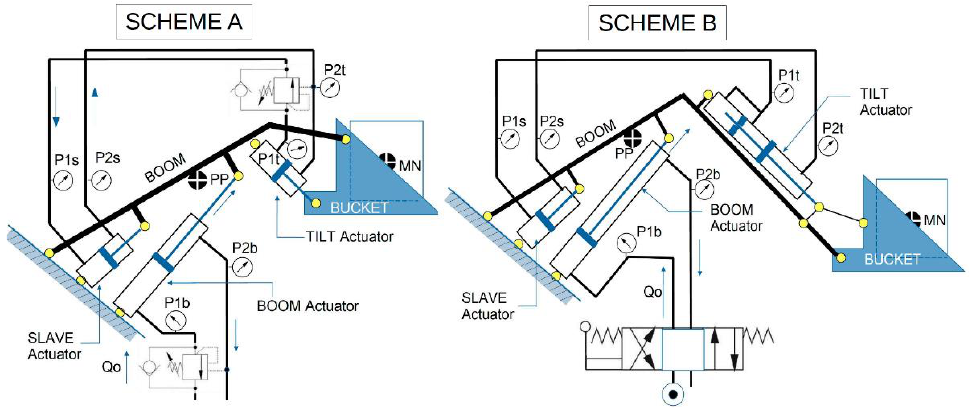
Figure 2. Schemes of the proposed machines (different topologies).